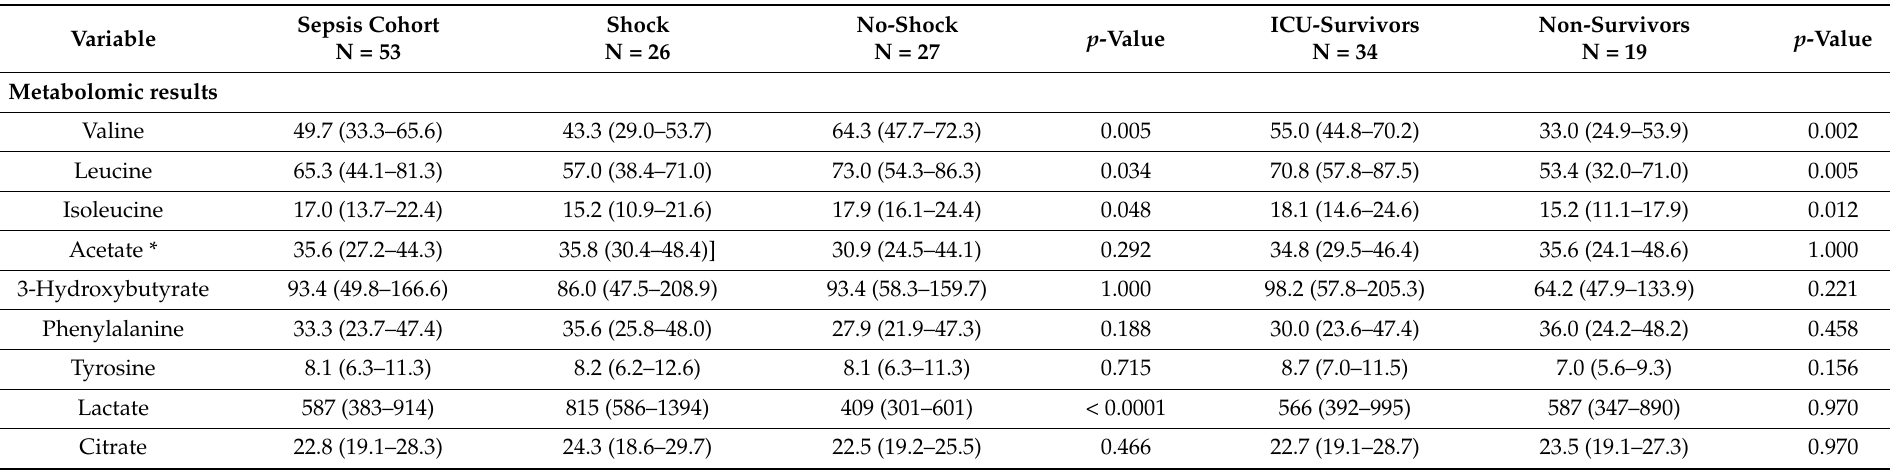
Table 3. Assigned and most prominent metabolic changes with sepsis and septic shock determined by untargeted 1 H NMR